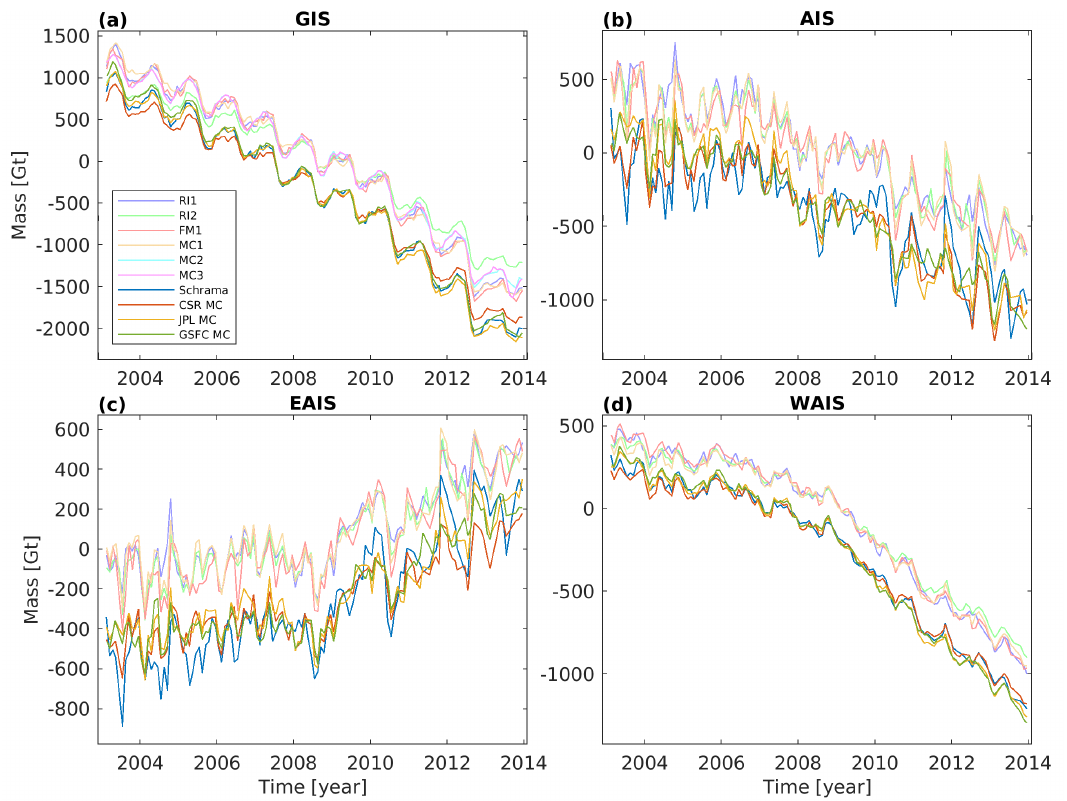
Figure 16. Comparison of GRACE-derived mass change time series for ( a ) the GIS, ( b ) AIS, ( c ) East Antarctica and ( d ) West Antarctica from the participants (faint colours) with alternative results (bold colours), namely, the updated time series from Schrama et al. [16] and time series extracted from the mascon products provided by CSR, JPL and GSFC. The alternative results are shifted along the y-axis to increase